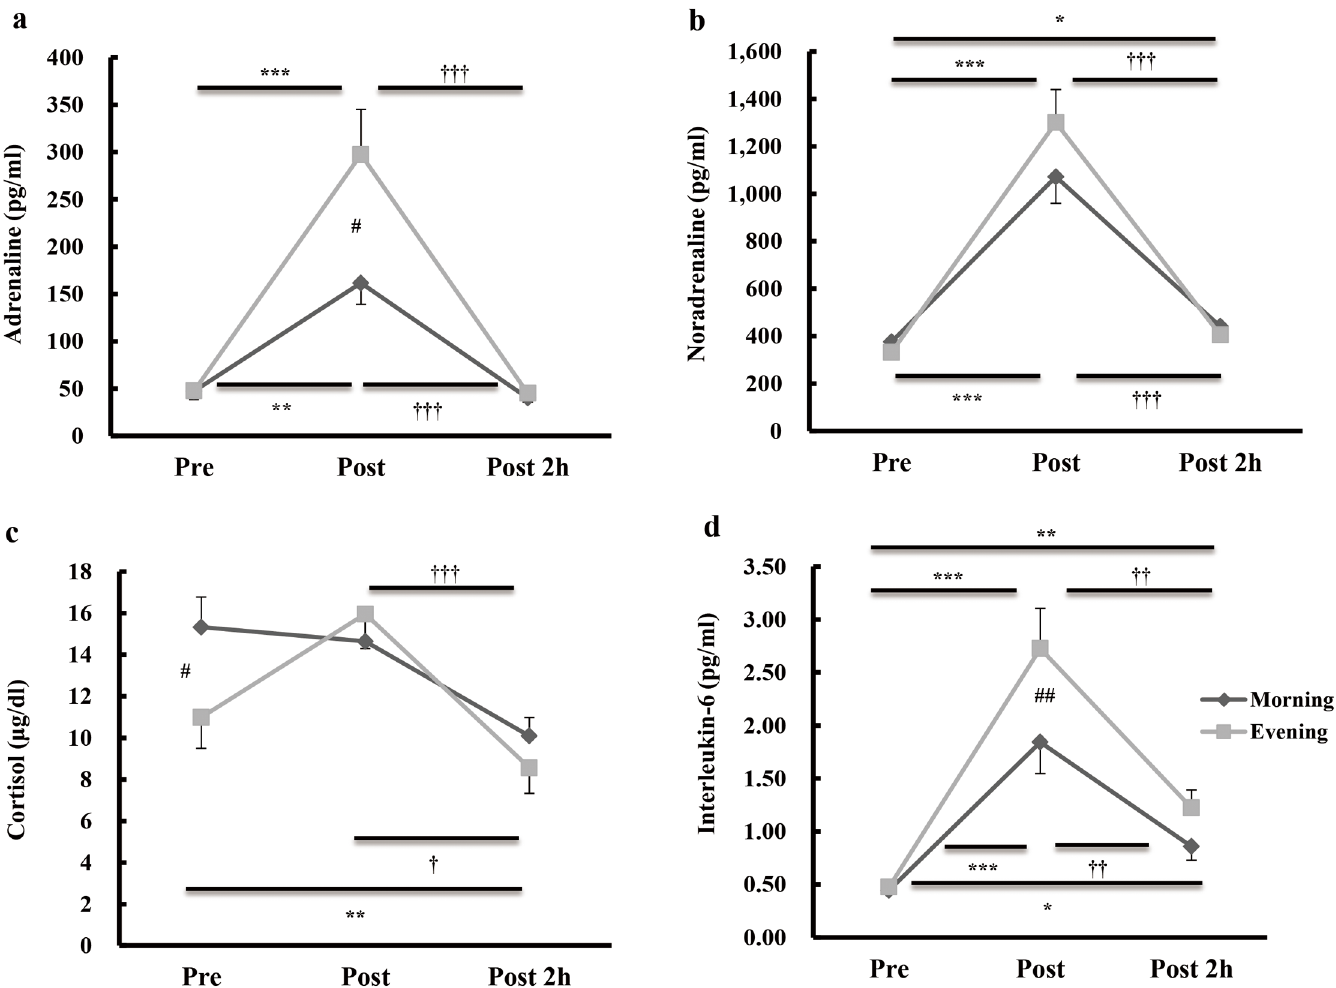
Fig 1. Changes in plasma hormone and IL-6 during morning and evening of acute endurance exercise. Plasma concentrations of adrenaline (a), noradrenaline (b), cortisol (c) and interleukin-6 (d) before (Pre), immediately after (Post), and 2 h after (Post 2 h) exercise. Data represent the mean ± standard error. * P < 0.05, ** P < 0.01, and *** P < 0.001, compared with values at pre-exercise. † P < 0.05, †† P < 0.01, and ††† P < 0.001, compared with values immediately after exercise. # P < 0.05 and ## P < 0.01, significant difference between the morning and evening values.